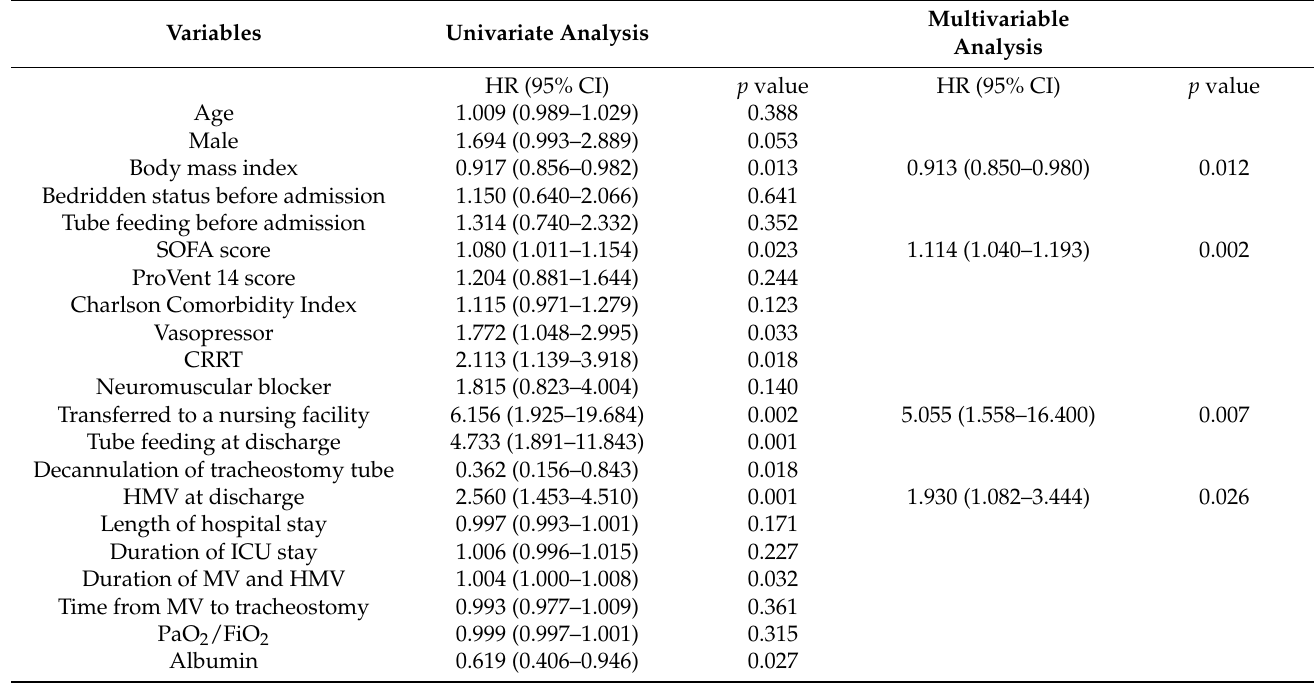
Table 3. Univariate and multivariable Cox proportional analyses of the variables associated with 1-year